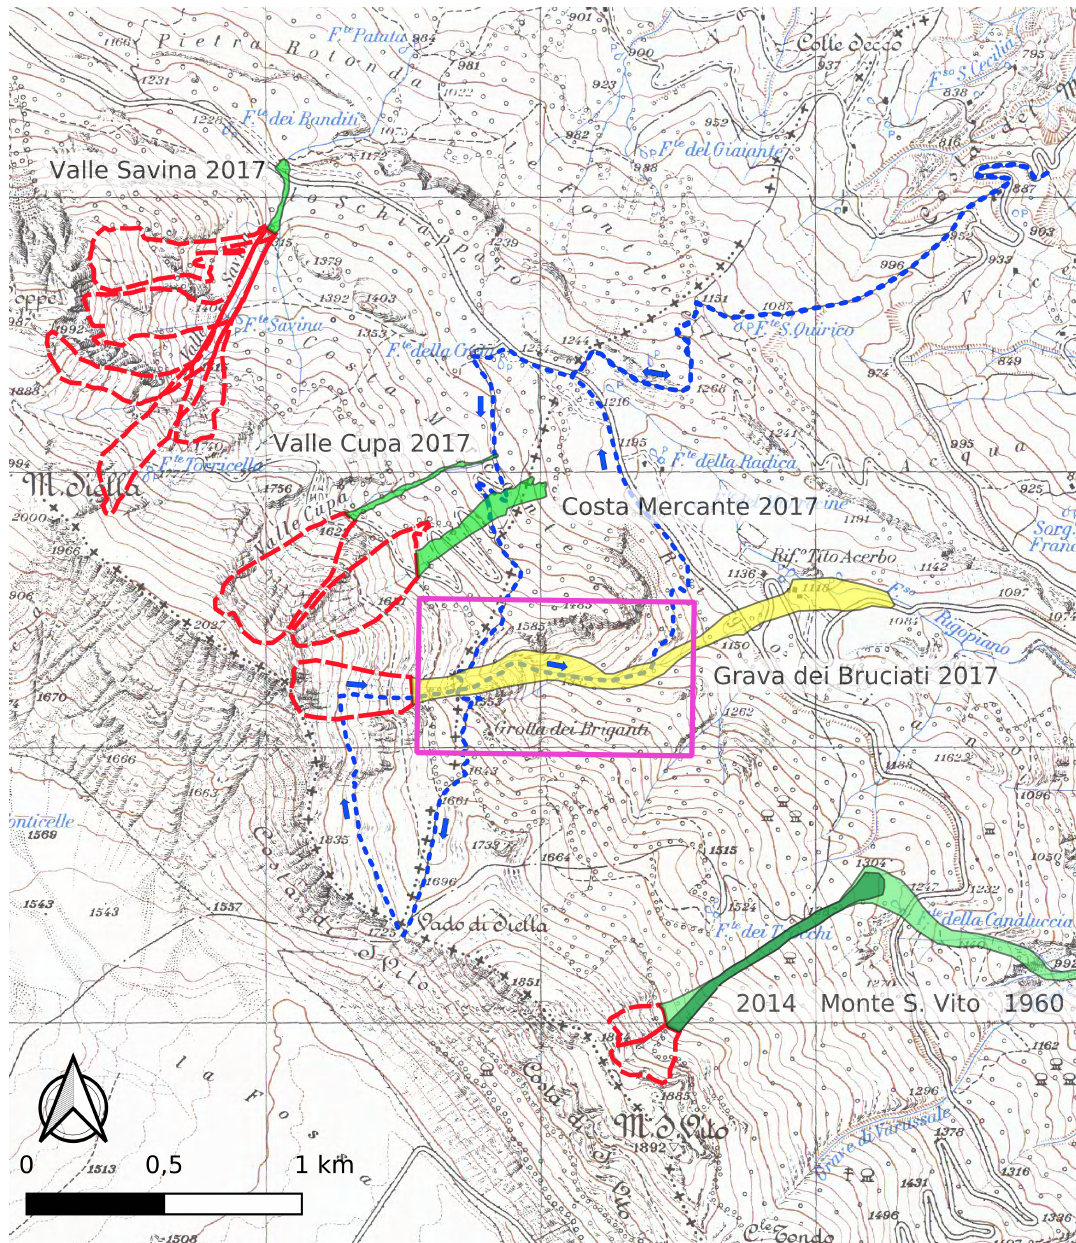
Figure 1. Topographic map of the Monte Siella area with the largest known avalanche events in each path (lower track and run-out areas shown as yellow and green polygons, potential release and upper-track areas as red dashed polygons). From North to South: Grava di Valle Savina (2017, based on information by D. Borgheggiani), Grava di Valle Cupa and Grava di Costa Mercante (both 2017, data from author’s survey and Google Maps orthophotos), Grava dei Bruciati (2017, from Google Maps orthophoto, author’s survey, and [8]), and Monte San Vito (1963, run-out beyond map to approximately 700m a.s.l., and 2014, communicated by D. Borgheggiani). Author’s survey itinerary on 3 June 2017 in blue dotted line. The purple rectangle indicates the area shown in Figure 5. Equidistance of isolines 25m. Basemap downloaded from